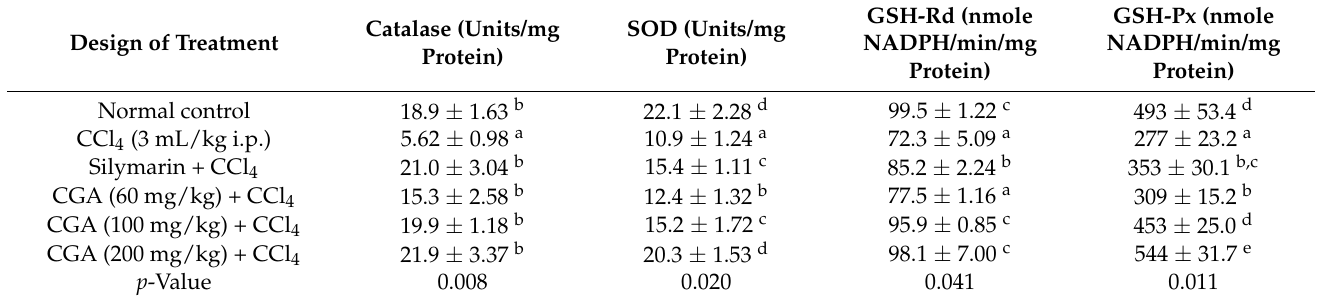
Table 2. Effects of CGA on hepatic catalase, SOD, GSH-Rd, and GSH-Px in CCl 4 intoxicated mice.